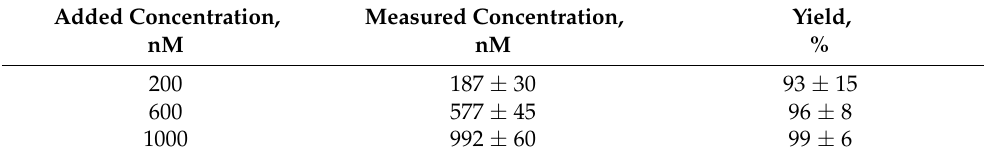
Table 3. The analytical yield of the DGT-BDS method for determination of Fe(II) in water. Added Concentration, Measured nM